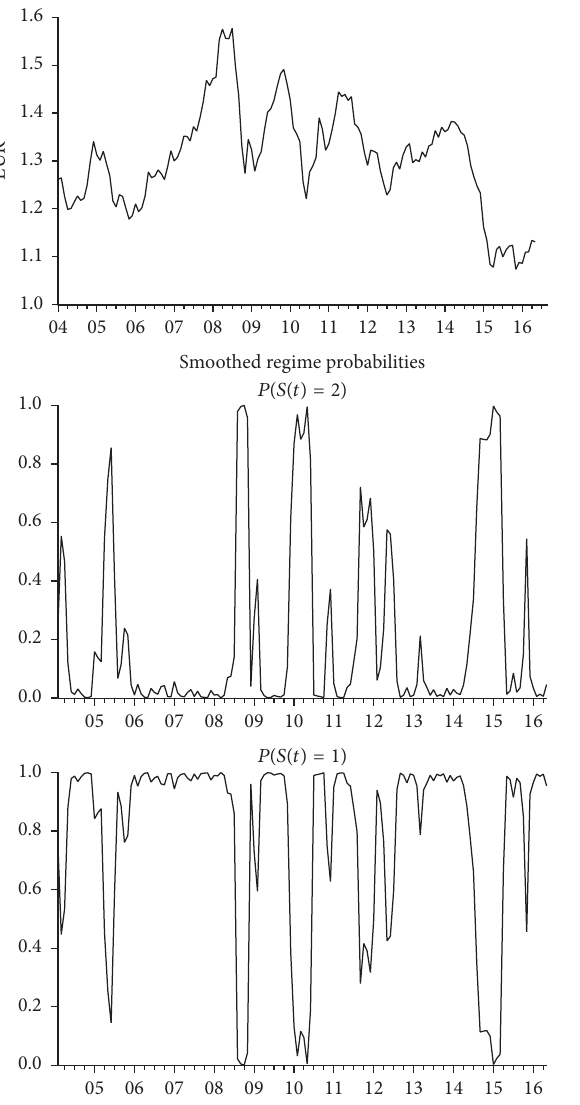
Figure 4: Time and smoothed probability plots of USD/GBP for